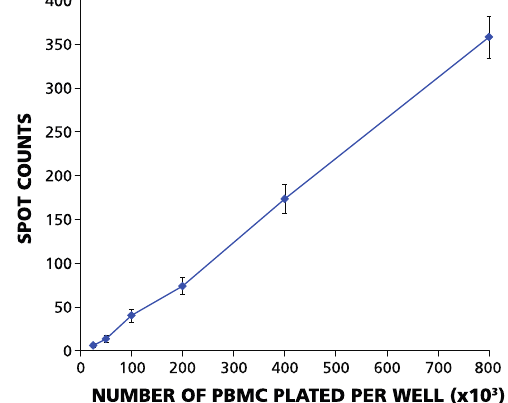
Figure 1. ELISPOT counts and plated PBMC numbers have a linear relationship in the range between 2.5 × 10 4 and 10 6 PBMC per well. The PBMC of an HLA-A2-positive donor were plated for each of the cell numbers specified on the X-axis per well, with 120 replicates for each cell number. The mean number of IFN- γ spots elicited by EBV peptide LMP2A (426–434) from these 120 replicate wells is shown on the Y-axis. Error bars represent ±